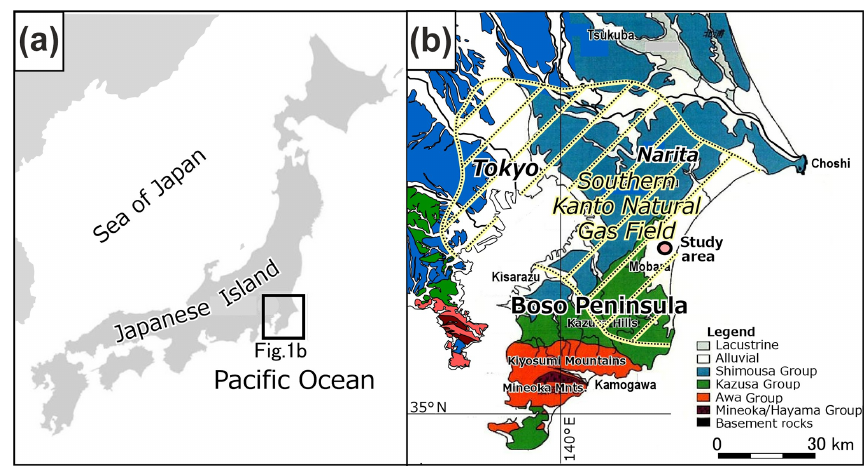
Figure 1. Location of the investigated area: (a) index map, (b) map showing the Southern Kanto Gas Field (modified from Ikeda et al., 2015, based on GSJ AIST, 2015) and GSJ geological maps as follows. Mitsunashi and Suda (1980), Mitsunashi et al. (1980), Sakamoto et al. (1987), Sudo et al. (1991), and Yoshioka et al.